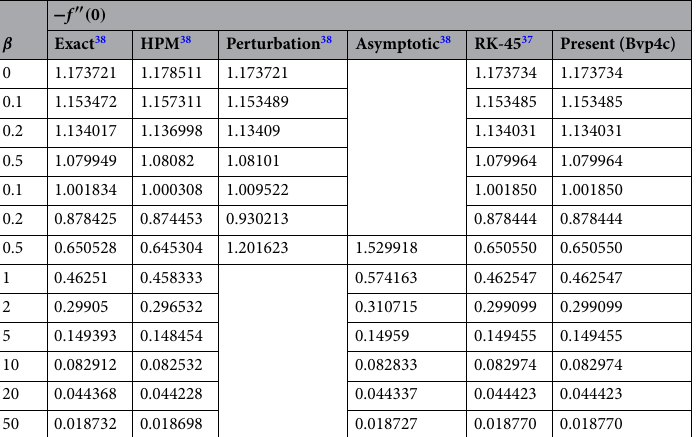
Table 2. Numerical and computational results for accuracy check of slip factor